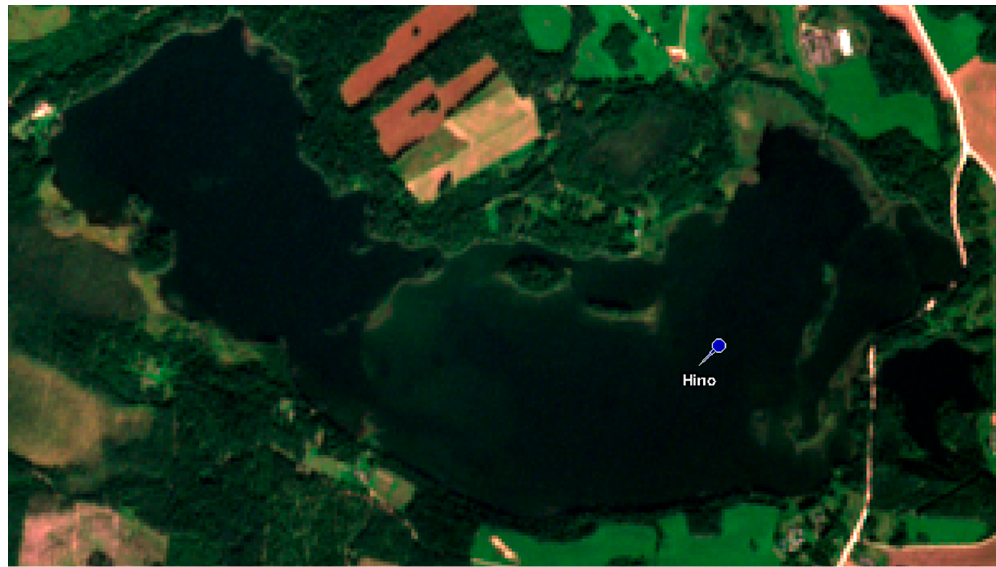
Figure A6. S2 MSI image of Hino from 30th of August 2017.